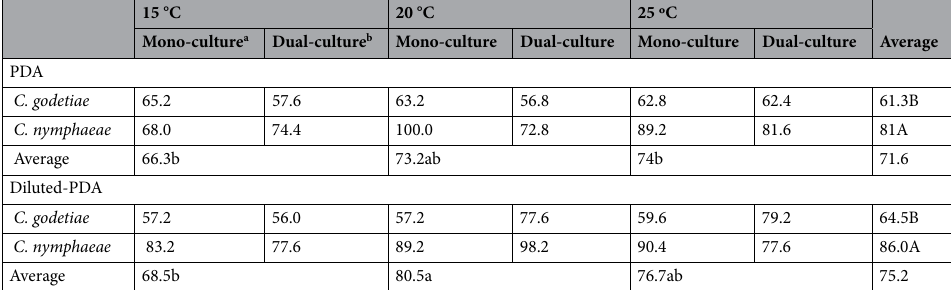
Table 1. Percentage of colony-forming units of the species Colletotrichum godetiae and C. nymphaeae on Potato Dextrose Agar (PDA) or Diluted PDA mono-cultured or dual-cultured and incubated at different temperatures. a Nine-cm Petri dishes with PDA or diluted-PDA prepared according to Sinclair and Dhingra (1995) were cultured with 50 conidia per dish of C. godetiae , C. nymphaeae , or a conidial mixture of both species (50:50%) b